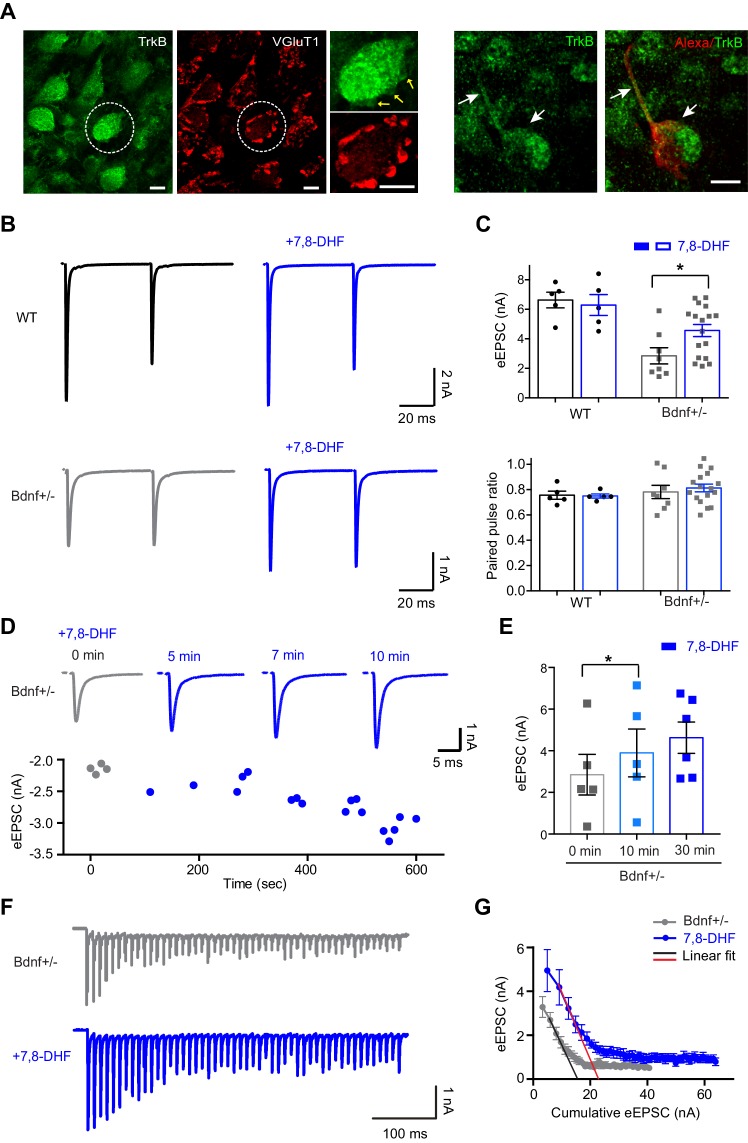
The activation of TrkB rescues decreased glutamate release at the calyx terminal.(A) Expression of TrkB (green) and VGluT1 (red) at calyx terminals in the MNTB from WT mice (P20). The calyx terminal and axon (arrows, P12 WT mice), filled with Alexa 568 during whole-cell recording, expressed TrkB (green). Scale bars, 10 μm. (B) Representative traces of eEPSCs in response to paired-pulse stimulation in the absence or presence of 7,8-DHF for WT (n = 5) and Bdnf+/– (n = 17) mice. (C) Summary of the effect of 7,8-DHF on the eEPSC amplitude (top) and the PPR (bottom). (D) Top, example of eEPSCs at 0, 5, 7, and 10 min after the acute application of 7,8-DHF. Bottom, the amplitude of eEPSCs is plotted against time after 7,8-DHF application. (E) Summary of the acute effect of 7,8-DHF on eEPSCs at different time points. (F) Representative traces of the eEPSC train at 100 Hz from Bdnf+/– mice in the absence (gray; n = 11) or presence of 7,8-DHF (blue; n = 7). (G) Plot of eEPSC amplitude against the amplitude of the cumulative eEPSC from Bdnf+/– mice in the absence (gray) or presence of 7,8-DHF (blue). The black and red lines represent the linear fit from the second through fourth cumulative eEPSCs. Data are shown as the mean ± s.e.m. *p<0.05 (unpaired t-test; paired t-test).